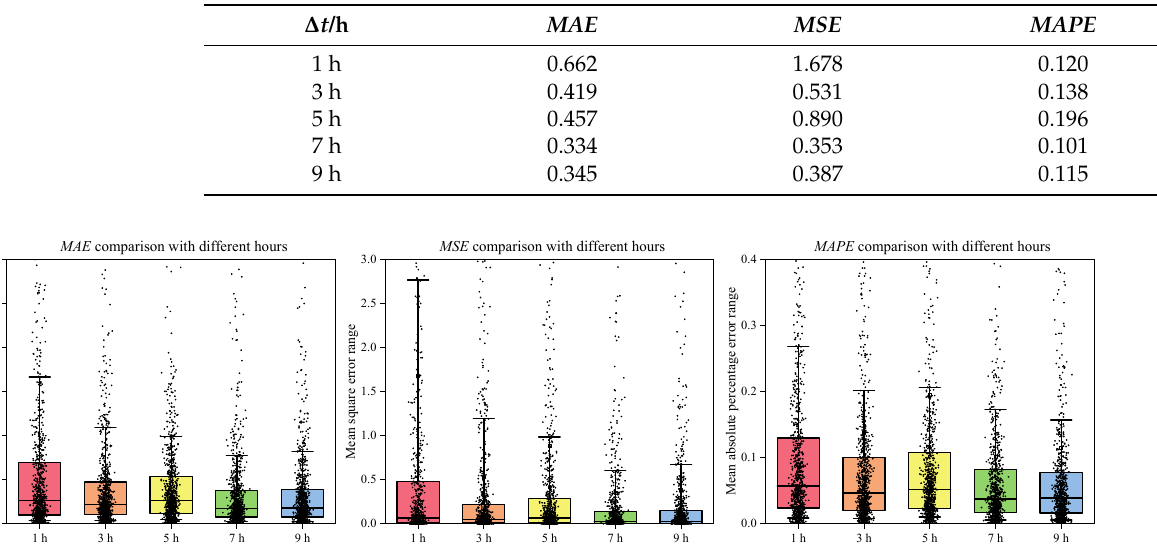
Figure 10. Errors comparison with different hours. MAE ( left ), MSE ( middle ), MAPE ( right ).